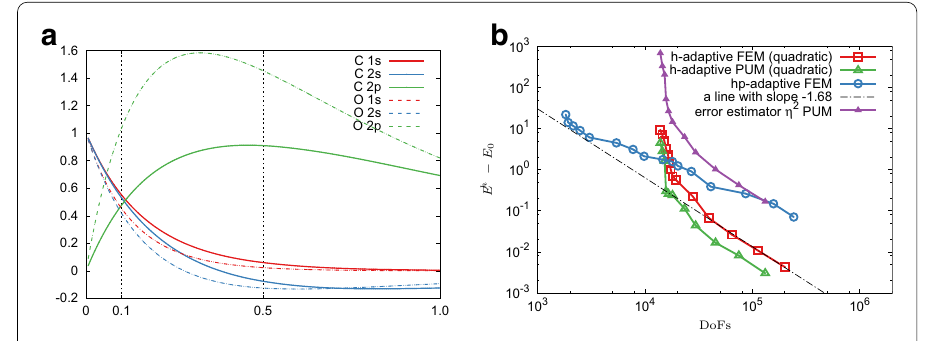
Fig. 6 Finite element solution of CO molecule. a Scaled radial solution of single atoms. The dotted vertical line at 0 . 5 indicates the enrichment radius. b Convergence of the error in total energy of CO molecule for various FE